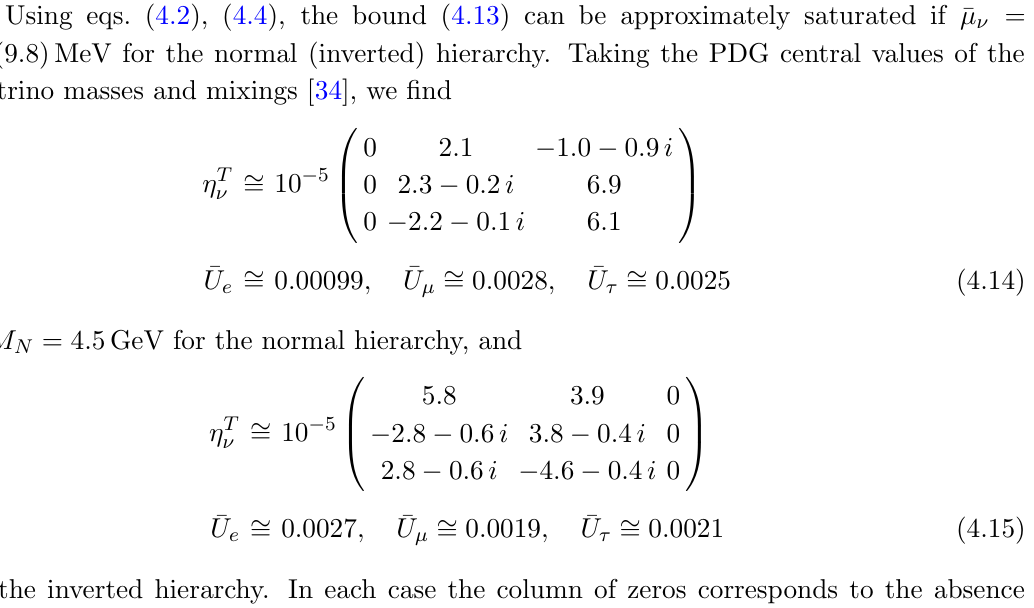
Figure 3 . Left: minimum allowed mass scale (cid:22) (cid:22) hierarchy case, compatible with current constraints on the HNL mixings to light neutrinos [14]. The shaded gray region is excluded. Right: the ratio r showing how the maximum allowed mixings (4.16) at M = 4 : 5 GeV are rescaled at lower M N